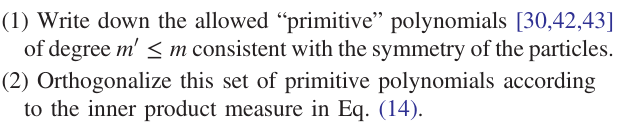
TABLE I. Summary of the PP construction for spinless par- ticles. Examples of this procedure are given in Sec.